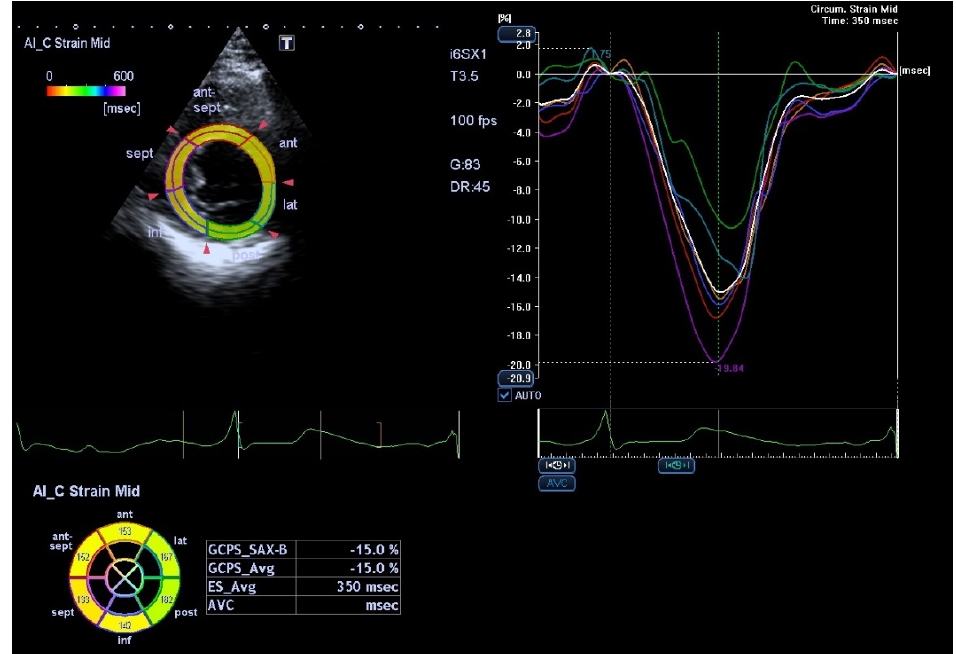
Figure 4. Echocardiography of a healthy pregnant patient showing circumferential left ventricle strain analysis (at the level of the papillary muscles) and speckle tracking analysis. GCPS_SAX-M-Global circumferential strain peak systolic middle left ventricle; GCPS_Avg-Average global circumferential strain; ES_Avg-Average End systolic time. Courtesy of the Fetal Medicine Foundation.